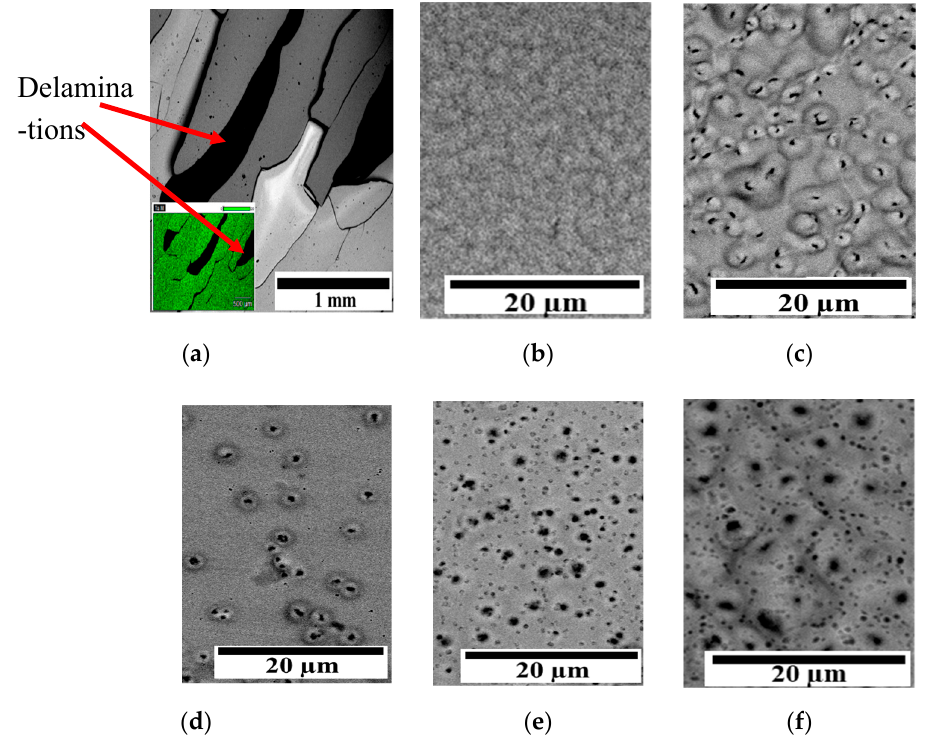
Figure 6. Top-view SEM images of coatings 1(Ar) ( a , b ), 2 (5 sccm N 2 ) ( c ), 3 (10 sccm N 2 ) ( d ), 4 (5 sccm C 2 H 4 ) ( e ), and 5 (10 sccm C 2 H 4 ) ( f ) after air annealing with maximal temperature of 1000 °C. Insert on 1a shows the energy dispersive spectroscopy (EDS) map for Ta signal.